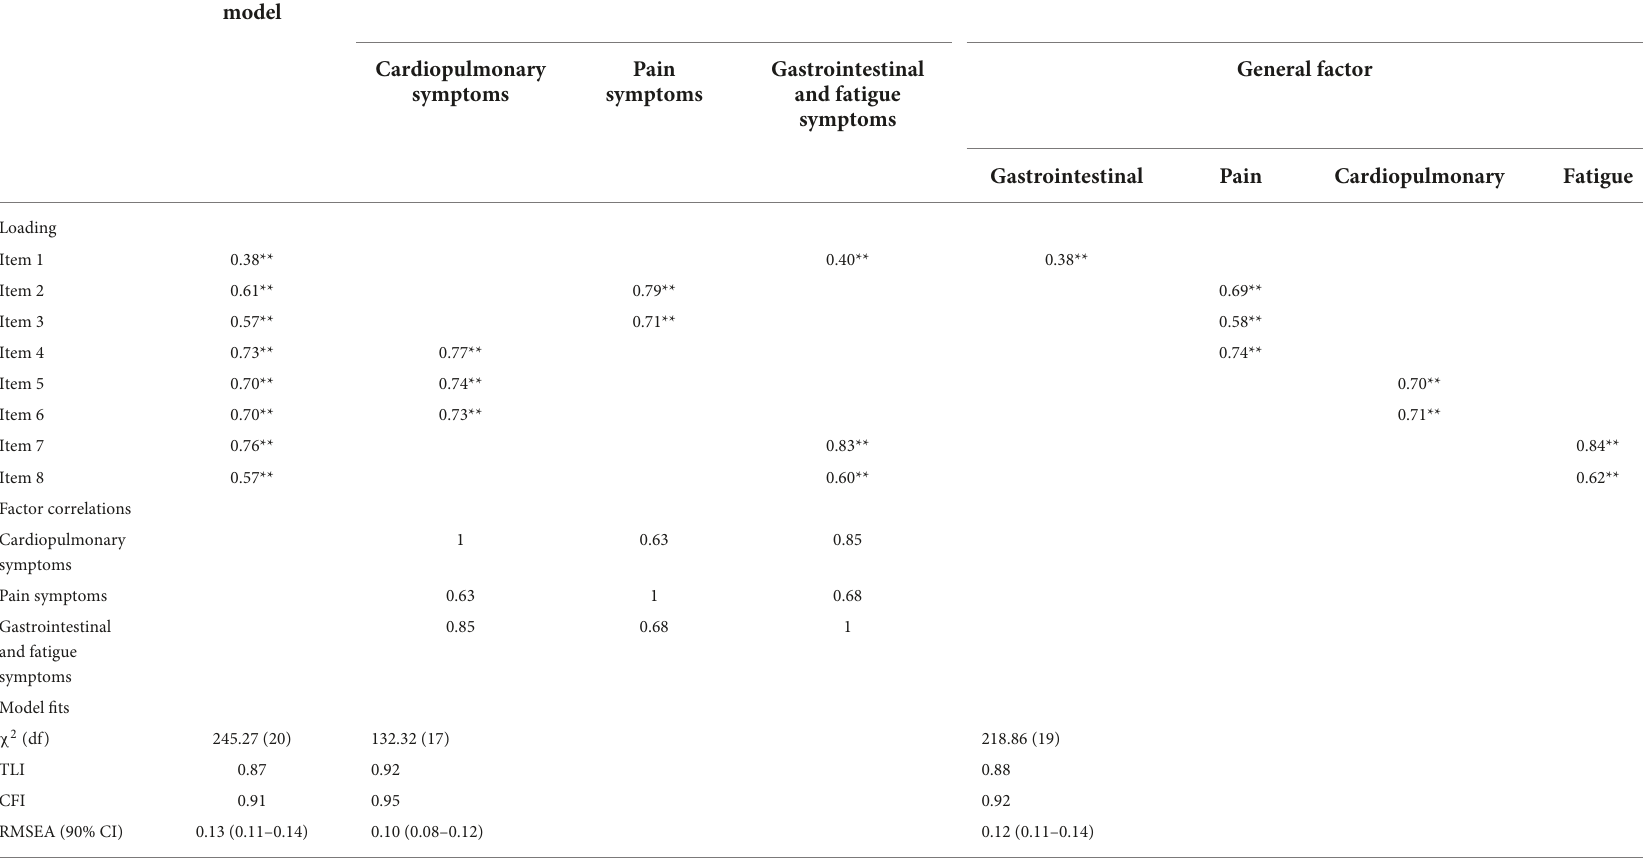
TABLE 3 Fit indices for three SSS-8 models from confirmatory factor analysis of total patients ( n =